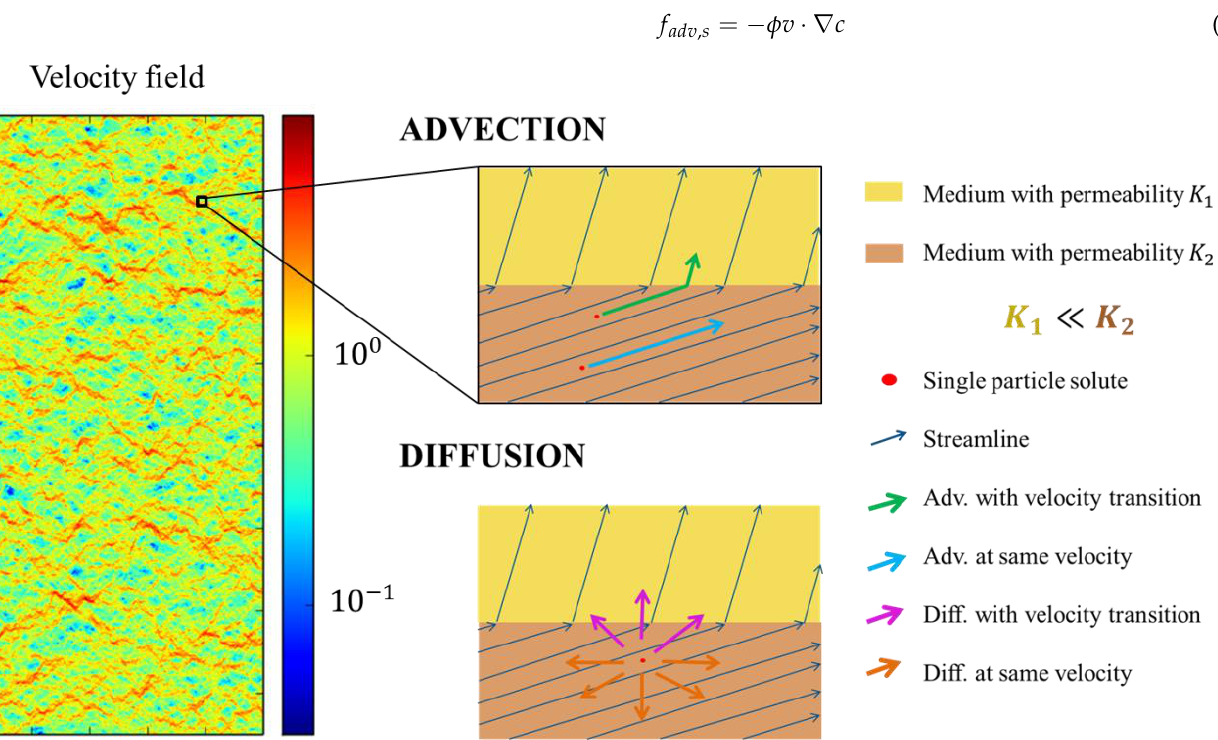
Figure 1. Scheme of particle transport processes through a continuum heterogeneous domain. The left image is a computed velocity field. The right-top image displays the advection path of two particles. The bottom-right image shows the diffusion possibilities of a single particle.